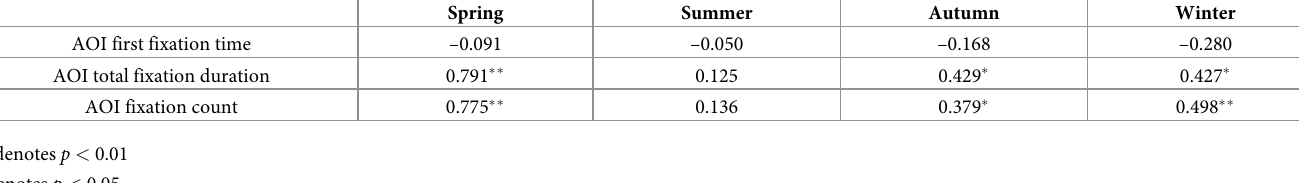
Table 5. Pearson correlation coefficient between visual behavior and landscape preference for forest color in different